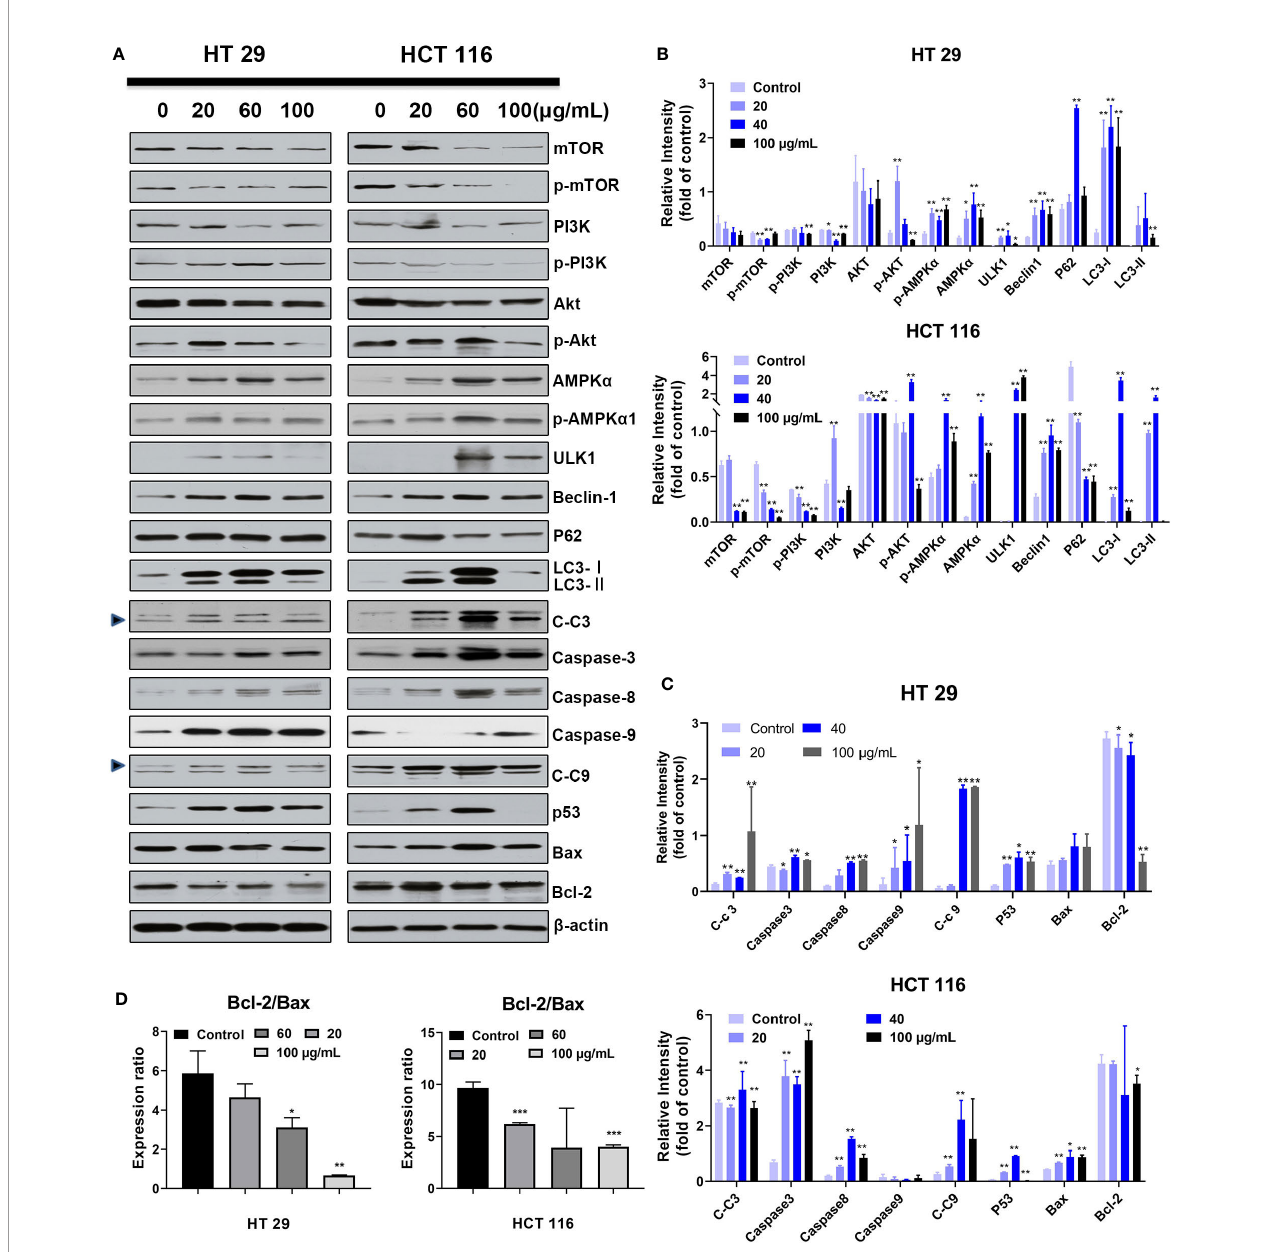
FIGURE 5 | Effect of SDEA on the expression levels of apoptosis- or autophagy-related key nodes induced by it. (A – C) dose effect of SDEA on the expression levels of apoptosis and autophagy-related proteins in HT29 or HCT116 cells ( n = 3, * p < 0.05; ** p < 0.01, vs. control group. C-c3 means cleaved-caspase-3, C-c9 means cleaved-caspase-9). (D) Ratios of Bcl-2/Bax induced by different SDEA concentrations for 24